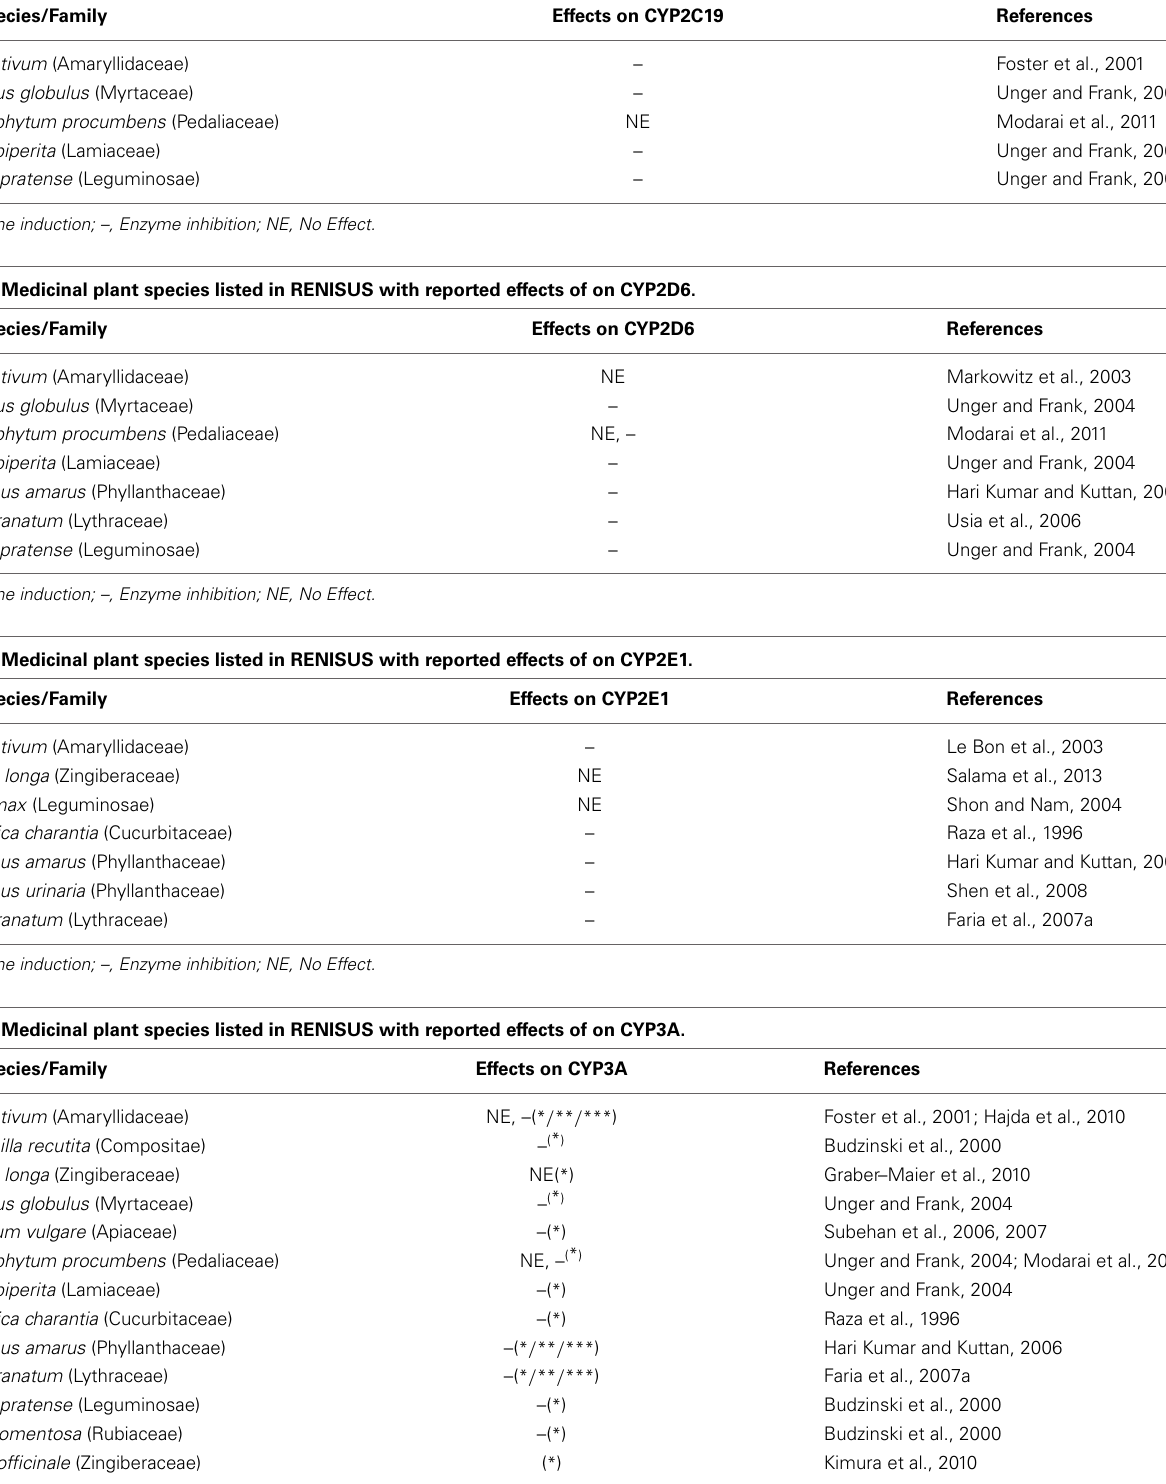
Table 3 | Medicinal plant species listed in RENISUS with reported effects of on CYP2C19. Plant species/Family